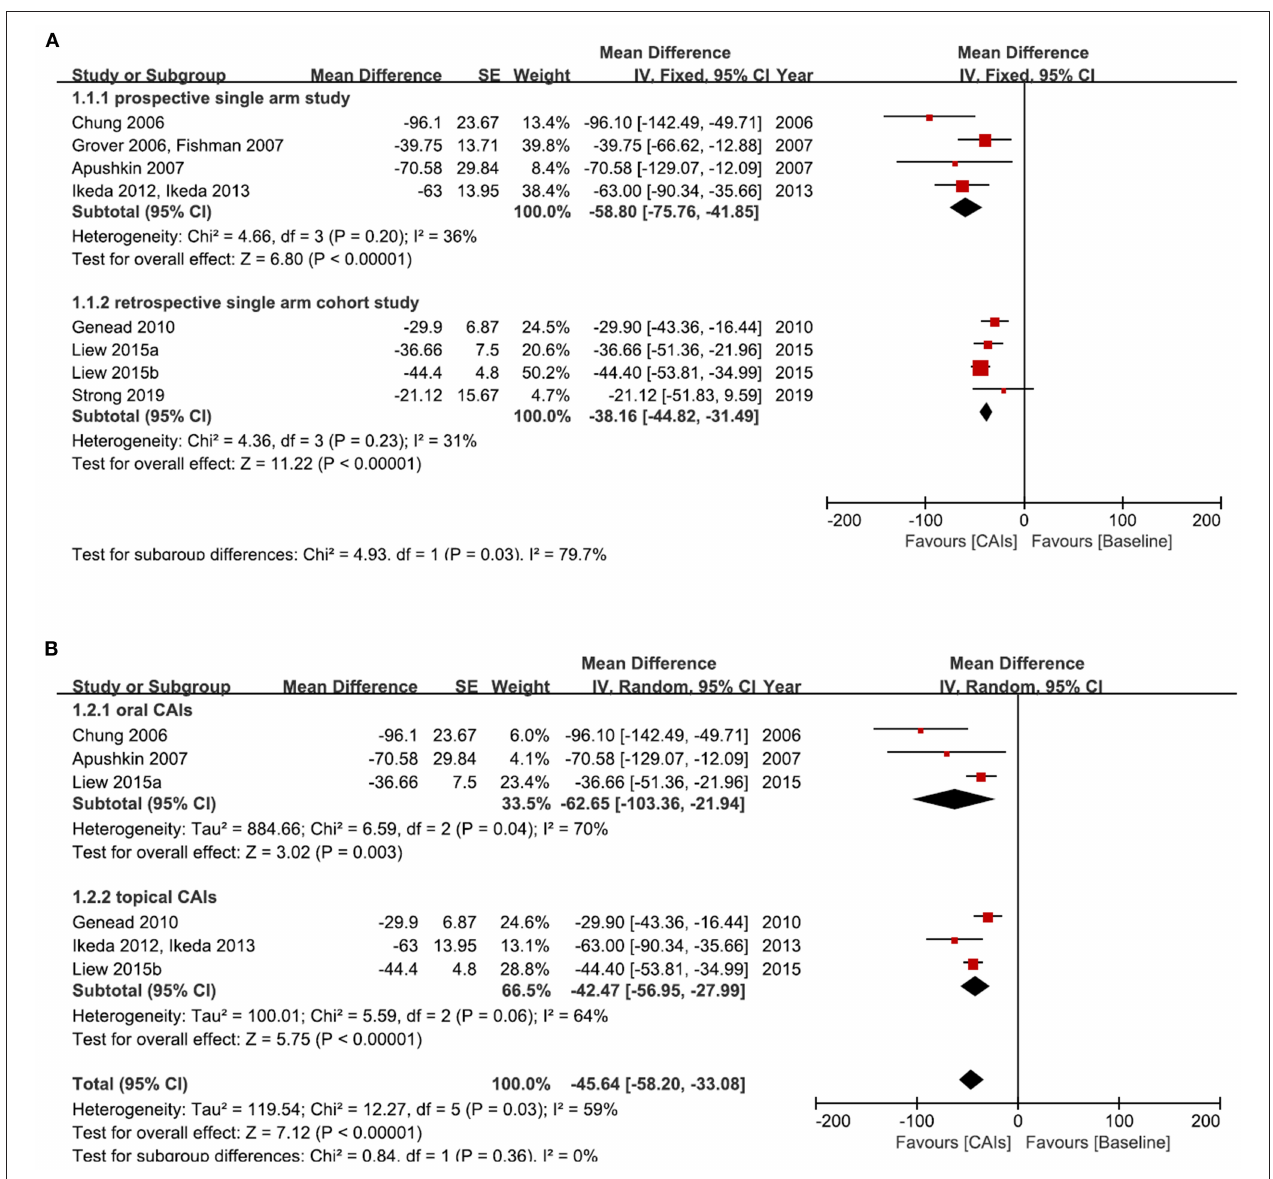
FIGURE 4 | Forest plots for the meta-analysis of change of central macular thickness (CMT) ( µ m) from baseline after carbonic anhydrase inhibitors (CAIs) treatment. (A) Meta-analysis of different study types; (B) Subgroup analysis according to different administration methods of CAIs. [For the studies Chung et al. (28), Grover et al. (30)/Fishman and Apushkin (7), Apushkin et al. (29), and Ikeda et al. (35, 39), the change of CMT was calculated from published original individual data; For the study Genead and Fishman (34), the change of CMT was calculated from the mean/standard deviation data before and after treatment; For the study Liew et al. (36), the change of CMT was calculated from the mean/95% CI of CMT reduction in responders and non-responders; For the study Strong 2019, the change of CMT was calculated from the mean/standard deviation data which was extracted from the box plot from the original article by Photoshop software] [*The study Strong 2019 was used for analysis in (A) but not in (B) because oral and topical CAIs treatment data cannot be separated in this study. The study Grover et al. (30)/Fishman and Apushkin (7) was used for analysis in (A) but not in (B) because this study may share some same patients with the study Genead and Fishman